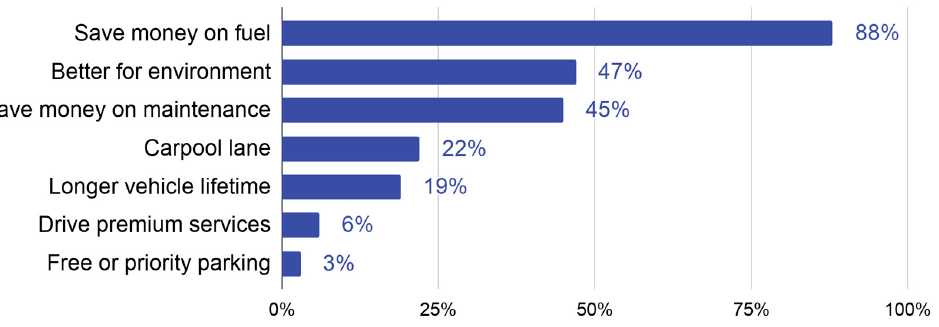
Figure 4. Reasons for choosing a PEV over an ICEV. Multiple answers allowed.